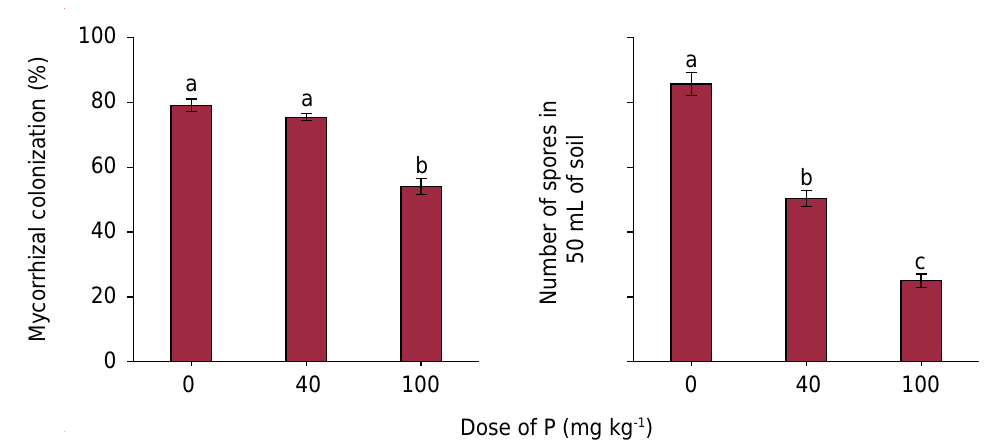
Figure 1. Mycorrhizal colonization and number of spores of Crotalaria juncea grown in a soil with high copper (60 mg kg -1 ) levels under different levels of phosphorus with and without AMF inoculation. Vertical bars above the columns indicate the standard deviation. Means followed by the same lowercase letter compare doses of P (Tukey 5 %).